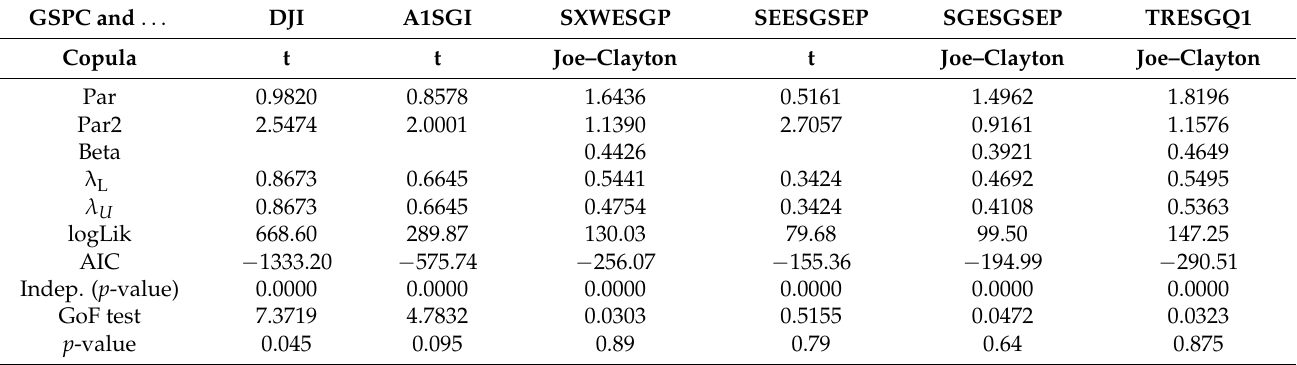
Table 2. Dependence structure for the GSPC and ESG indices, 3 July 2007–30 January